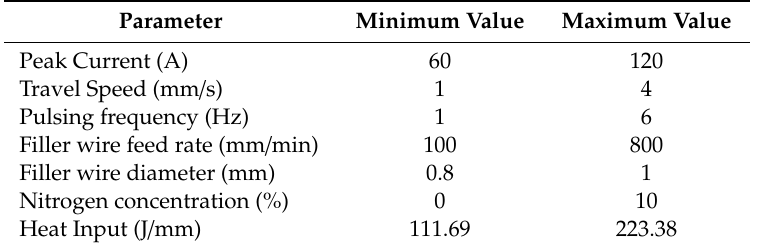
Table 2. Minimum and maximum limits of the variable inputs used for the